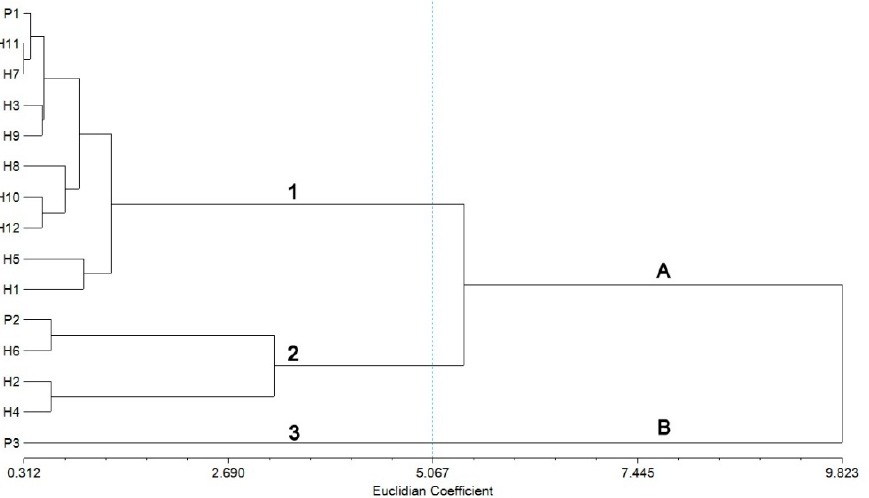
Figure 2. UPGMA morphological dendrogram showing the relationships between Streptocarpus parents and F1 hybrids.